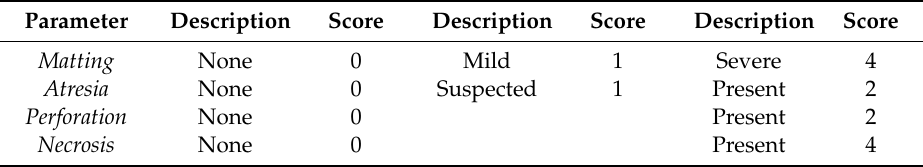
Table 1. The Gastroschisis Prognostic Score